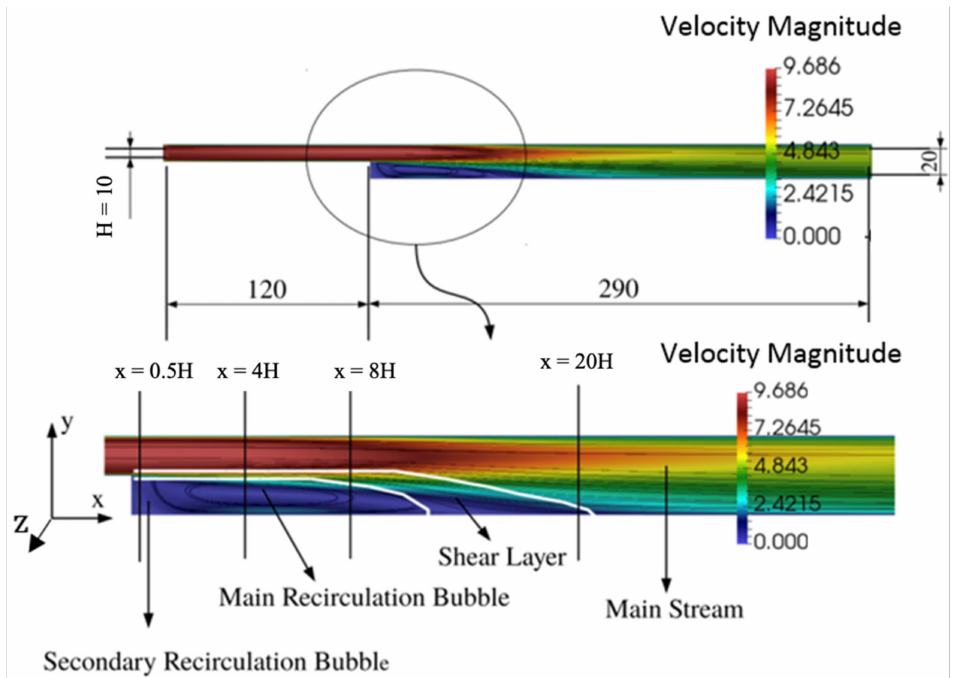
Figure 4. Top: geometry of the Backward-Facing Step (BFS) analyzed in this subsection. Bottom: main phenomena during the flow and vertical lines over which the axial velocity is analyzed. All units are nondimensional and the kinematic viscosity value is fixed for setting the Reynolds